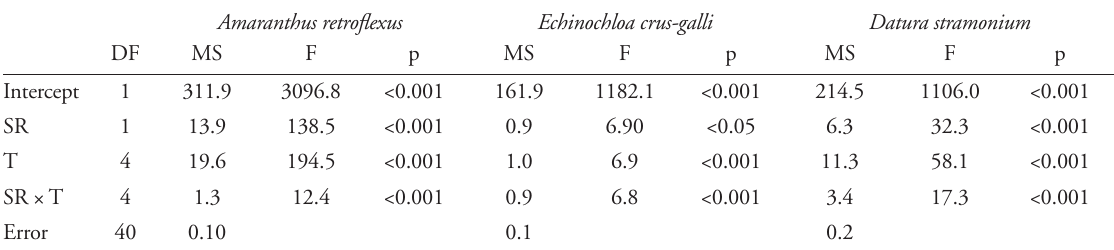
Table 2. Results of GLMs on the effect of region (SR) and temperature (T) on the seed germination rates of A. retroflexus , E. crus-galli , and D. stramonium (for details cf. Fig. 2). DF = degrees of freedom, MS = mean squares, F = F-statistics, p =